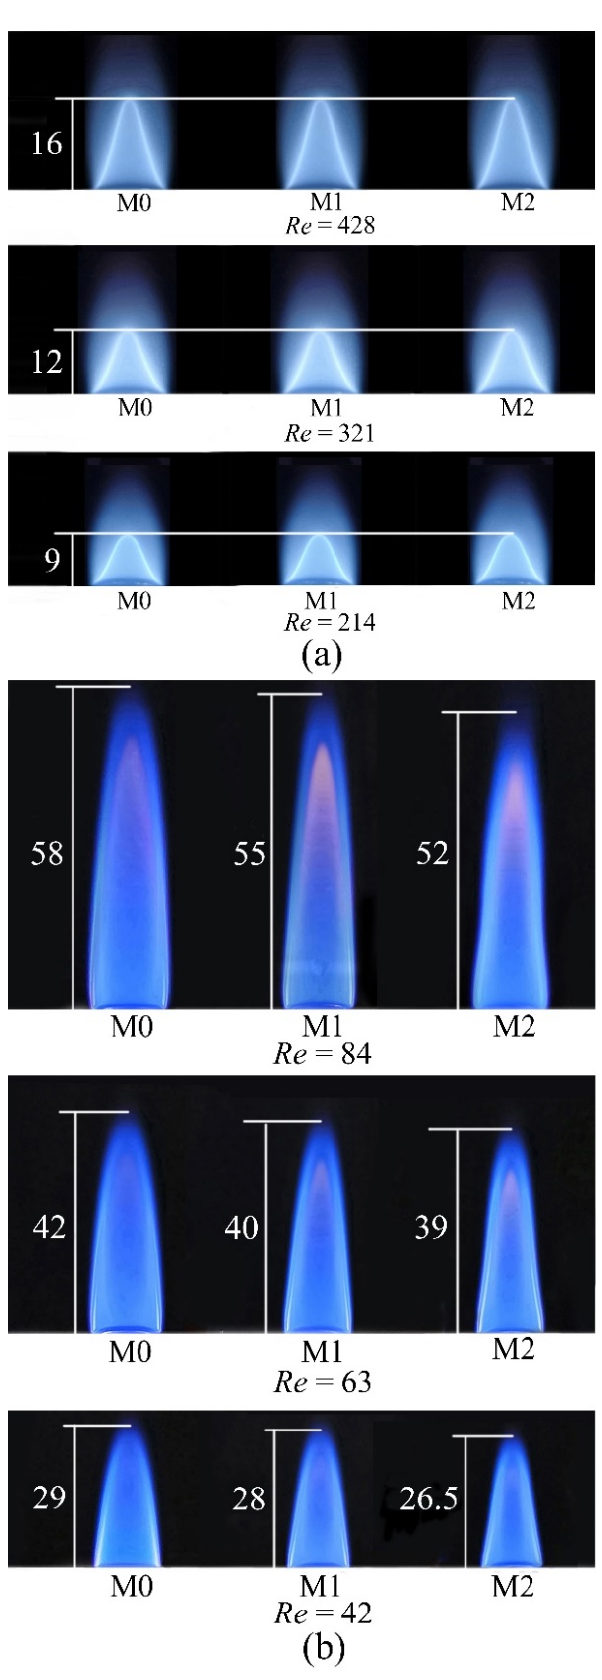
Figure 3. Photos of ( a ) premixed flames and ( b ) diffusion flames of different Reynolds numbers in three scenarios of magnetic fields (white numbers are flame heights with the unit of mm).